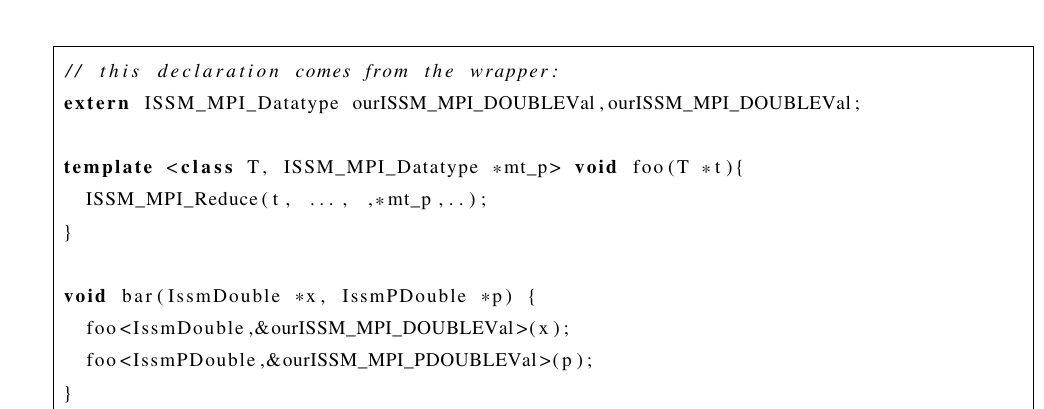
Figure 1. Code for wrapping reduction.